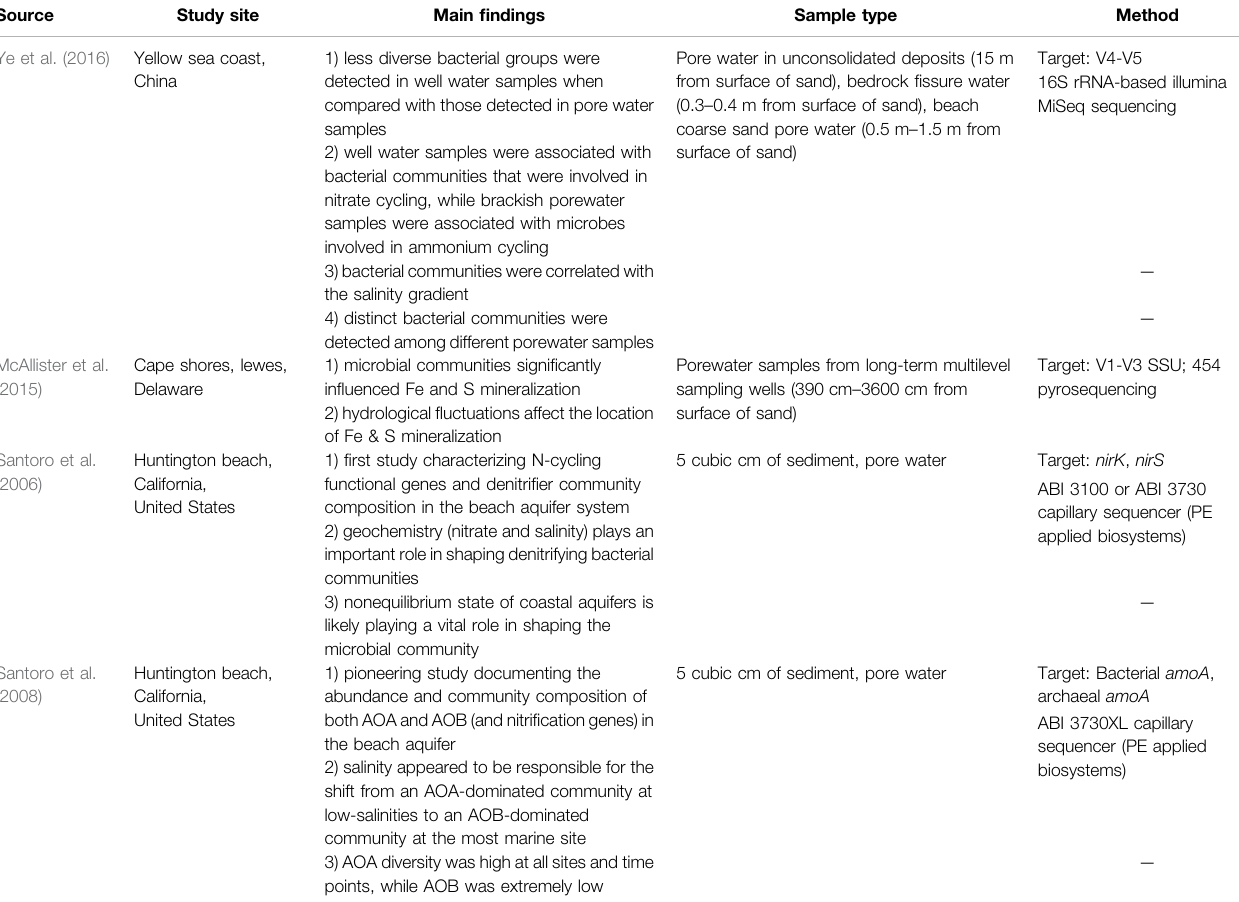
TABLE 1 | ( Continued ) Summary of fi ndings on microbial communities in beach